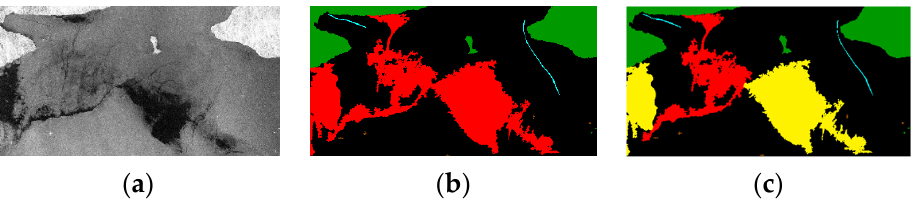
Figure 14. ( a ) Satellite image; ( b ) single ‘Oil Look-Alike’ type (red); ( c ) two ‘Oil Look-Alike’ types (red as Sharp and yellow as Patch Look-Alike).